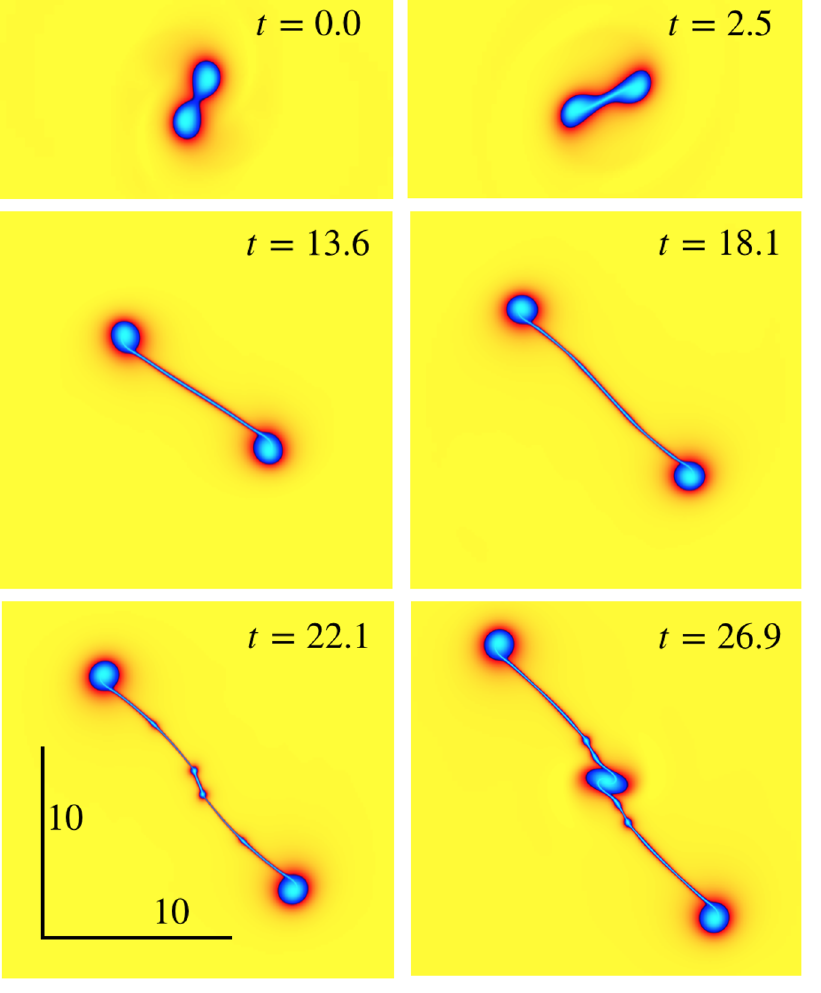
Figure 9 . 6 D -A evolution with v = 0 . 5 , a = 0 . 6 , b = 2 . 5